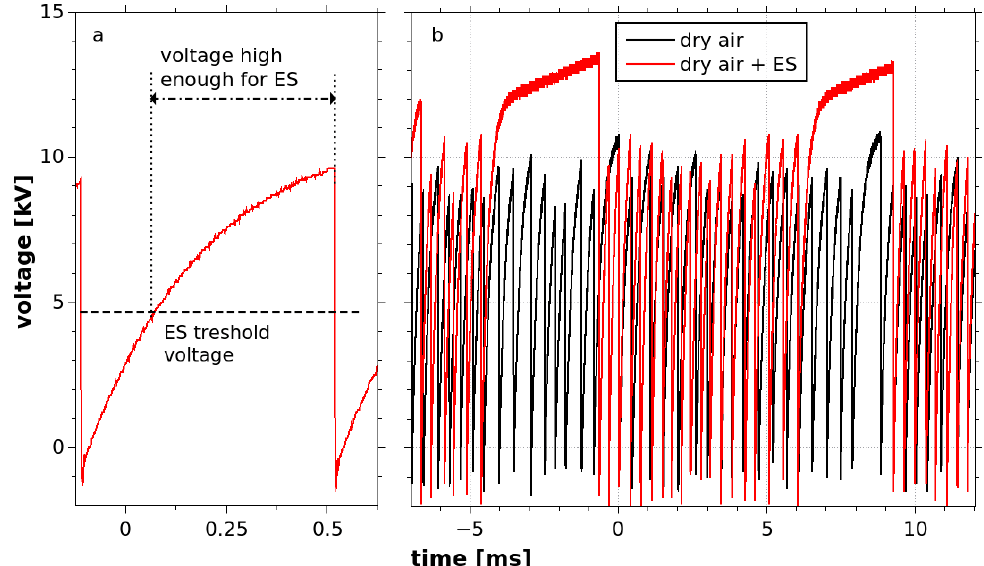
Figure 5. Typical long timescale TS voltage waveforms; ( a ) voltage increase regrowth between two voltage drops (gas breakdowns, i.e., TS pulses), showing that voltage is high enough for formation of microdroplets by ES most of the time; ( b ) voltage waveforms showing several tens of break- downs, comparison of voltage waveforms without (black) and with ES (red; water flow rate Q w = 300 μ L/min) where periods without breakdowns and TS current pulses appear (e.g., time period 6– 9 ms).